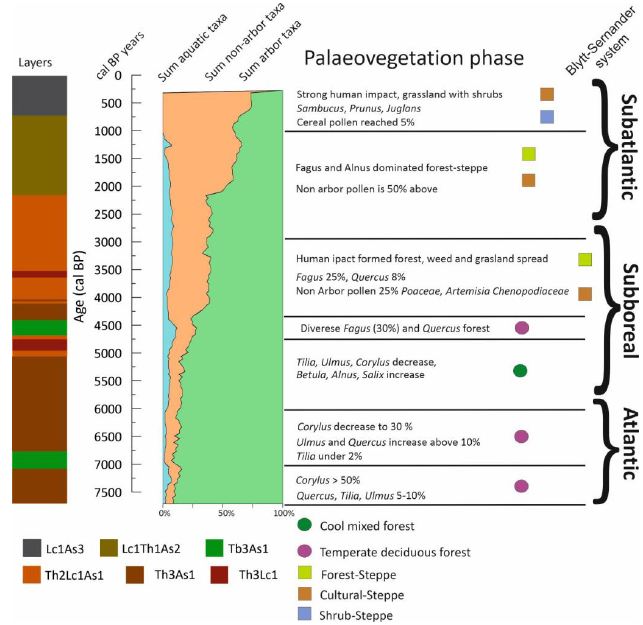
Figure 10. Summary of palaeovegetation phase and pollen taxa correlated with the Blytt-Sernander system. Between 6750–6500 cal BP years, the quantity of elements of mineral origin (Al, Si, K, Cr, Rb) increased, and organic components decreased in the erosion phase deposited to the peat level (Figure 10). The proportion of pollen of deciduous woody plants also de-